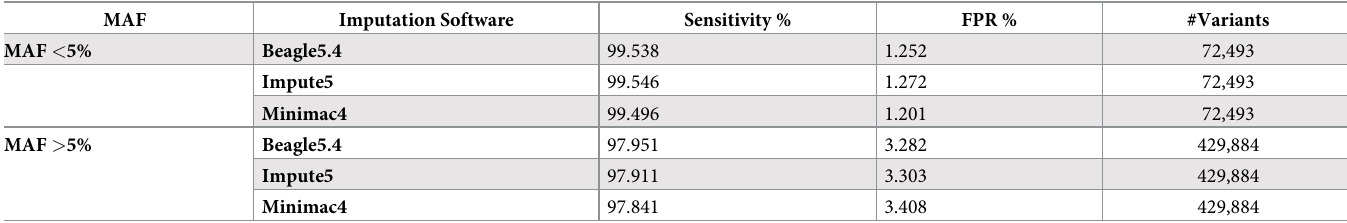
Table 3. MAF-stratified comparison of imputation software for EBB data. MAF